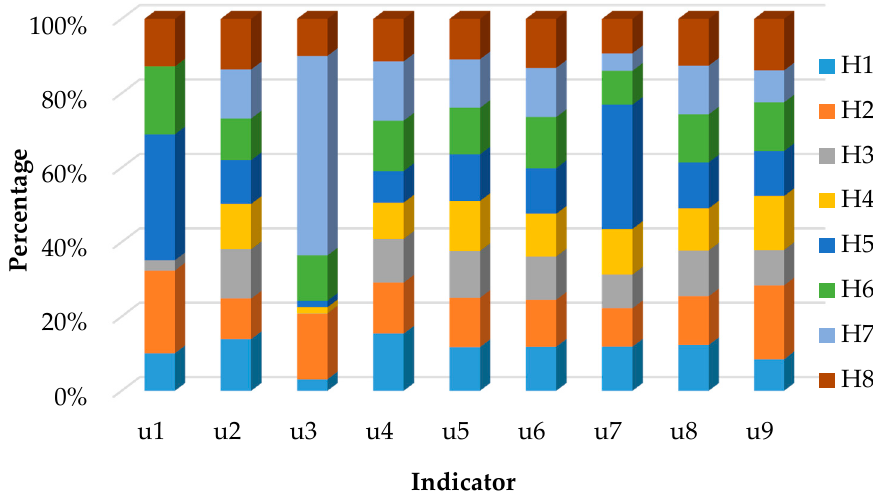
Figure 4. Proportions of indicators in eight regions.